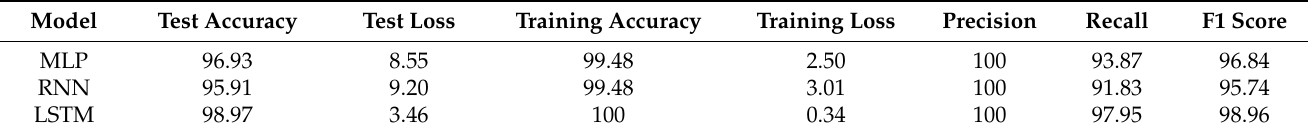
Table 2. Performance metrics of training and testing datasets with three neural network models.